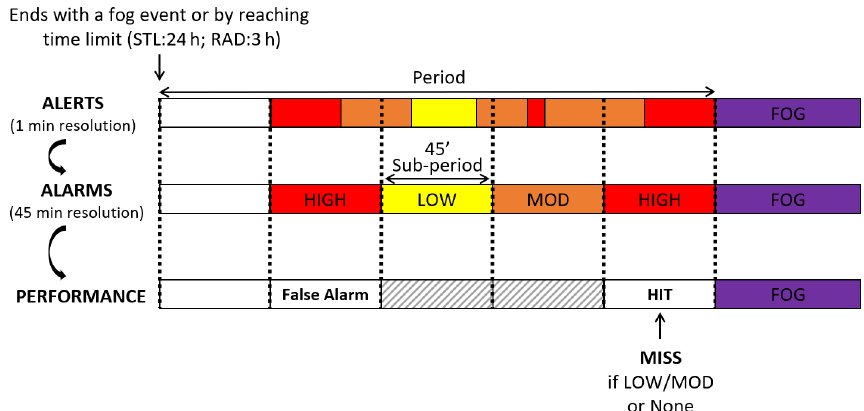
Figure 8. Diagram of the PARAFOG v2.0 assessment methodology. The alert colors represent PARAFOG v2.0 outputs with red for high alert, orange for moderate alert, and yellow for low alert.